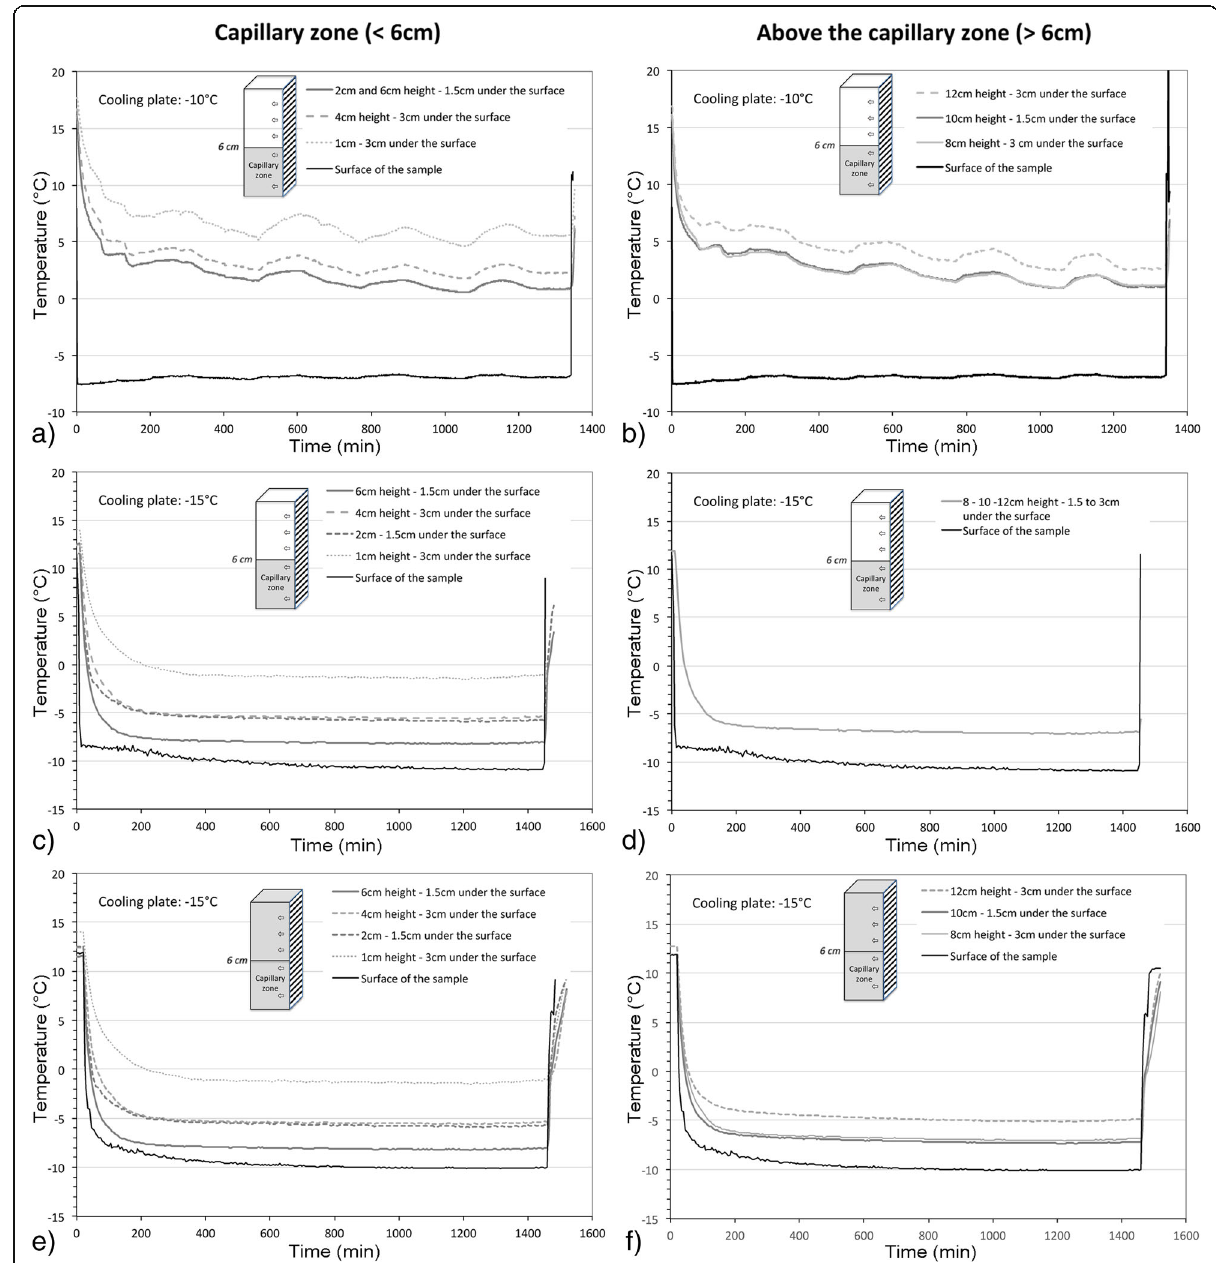
Fig. 5 Temperature kinetics inside the sample a , c , e in the capillary zone and b , d , f above the capillary